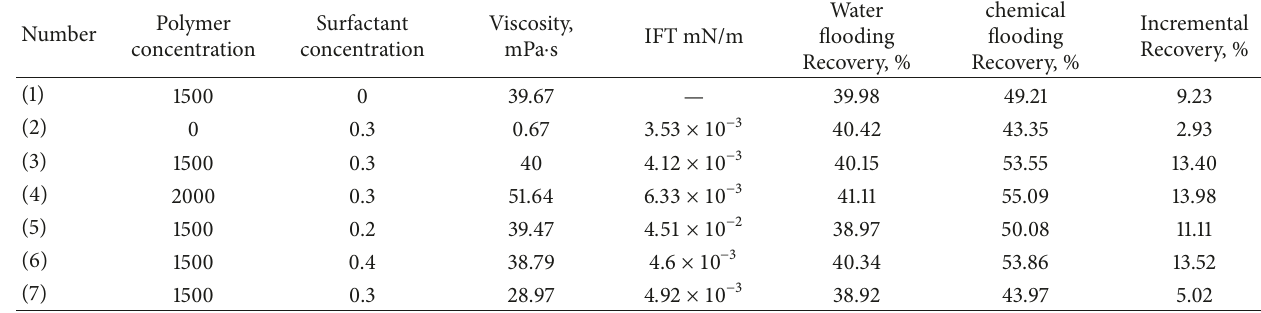
Table 4: Experiment data of oil displacement efficiency.